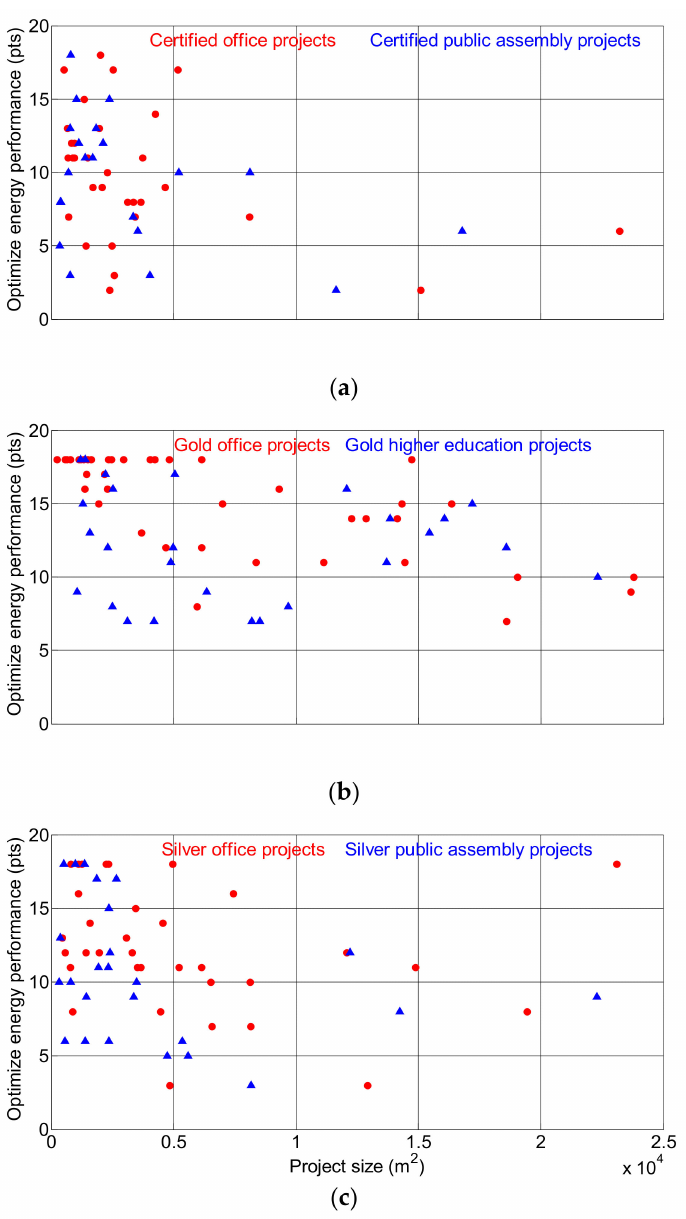
Figure 1. Relationship between LEED-NC v4 project size and Optimize Energy Performance credit in three cases of project spaces: ( a ) office (red circle) and public assembly (blue triangle) projects at the certified level (top panel), ( b ) office (red circle) and higher-education (blue triangle) projects at the gold level (middle panel), and ( c ) office (red circle) and public assembly (blue triangle) projects at the silver level (bottom